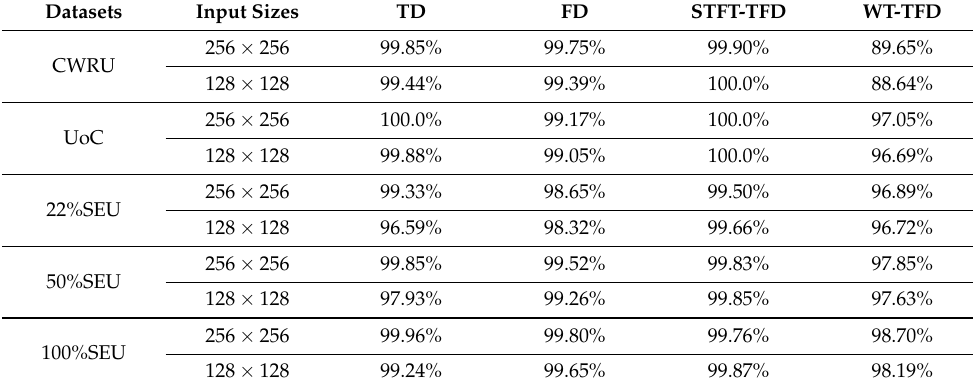
Table 11. Test accuracies of the evaluation with trend items.